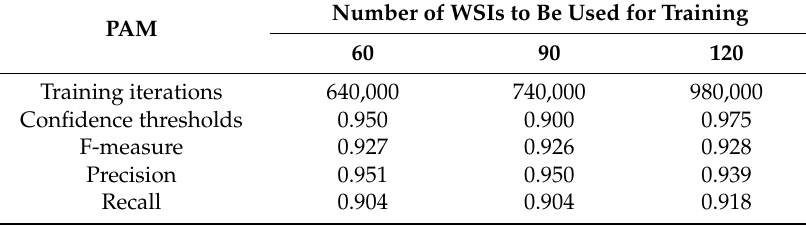
Table A2. Details of detection performance corresponding to the number of WSIs to be used for training the network (PAM).